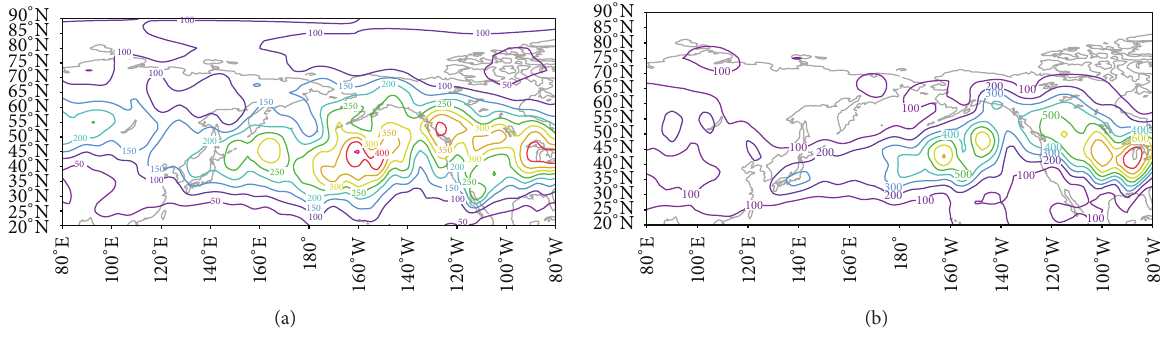
Figure 7: (a) 𝑉 1𝑑𝑓 for Nov-Dec 2013. (b) 𝑉 1𝑑𝑓 for 1–23 Jan 2014. Units: ( m 2 s −2 ) .